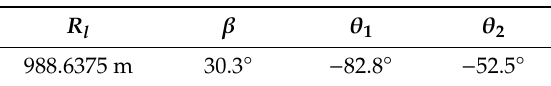
Table 1. Simulation curve